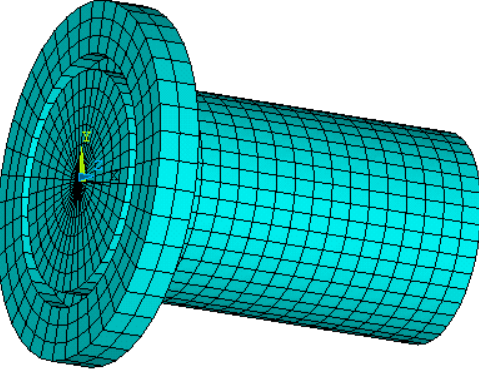
Figure 3. Horn model and grid partition.